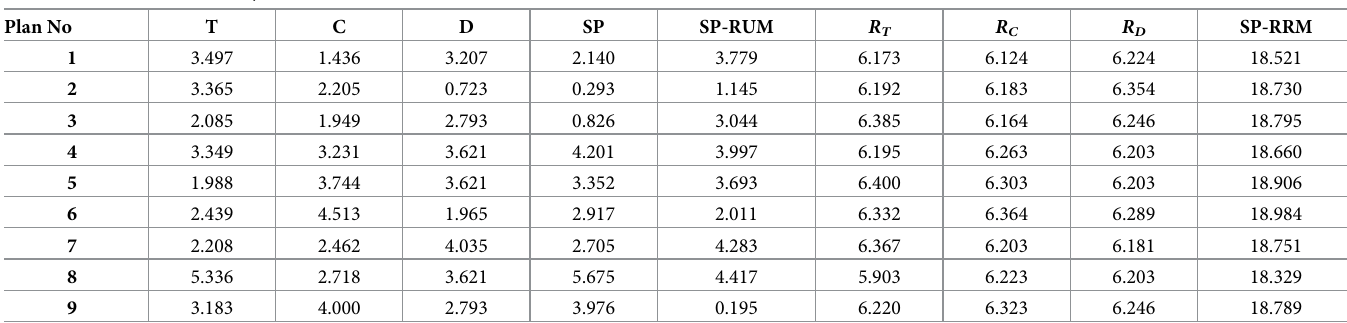
Table 9. The results of SP-only, SP-RUM and SP-RRM model.